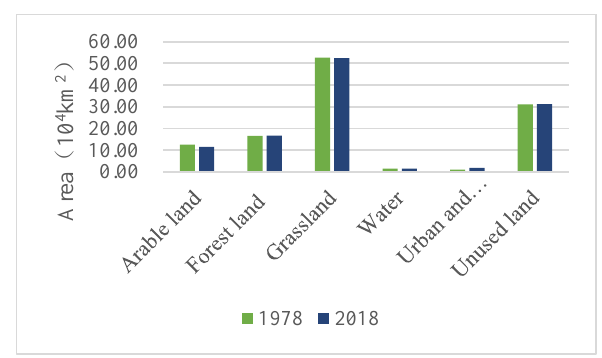
Figure 4. Comparison of land use area in 1978 and 2018 Table 1 Change rate of land use types in Inner Mongolia Autonomous Region from 1978 to 2018 (positive values